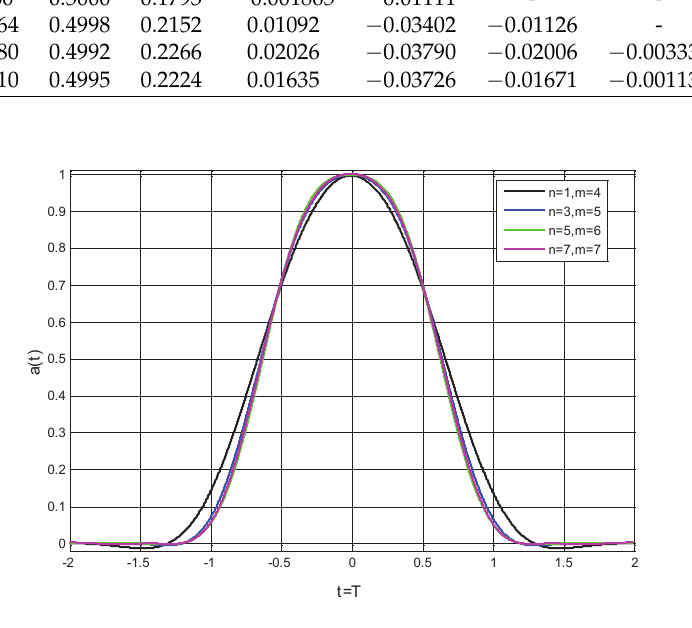
Figure 4. Waveform of the optimized baseband